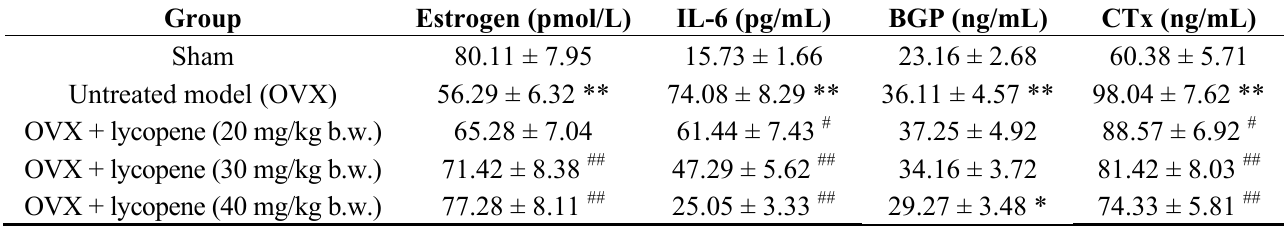
Table 3. Effect of lycopene on serum estrogen, IL-6 and BGP levels in experimental rats. Group Estrogen (pmol/L) IL-6 (pg/mL) Sham Untreated model